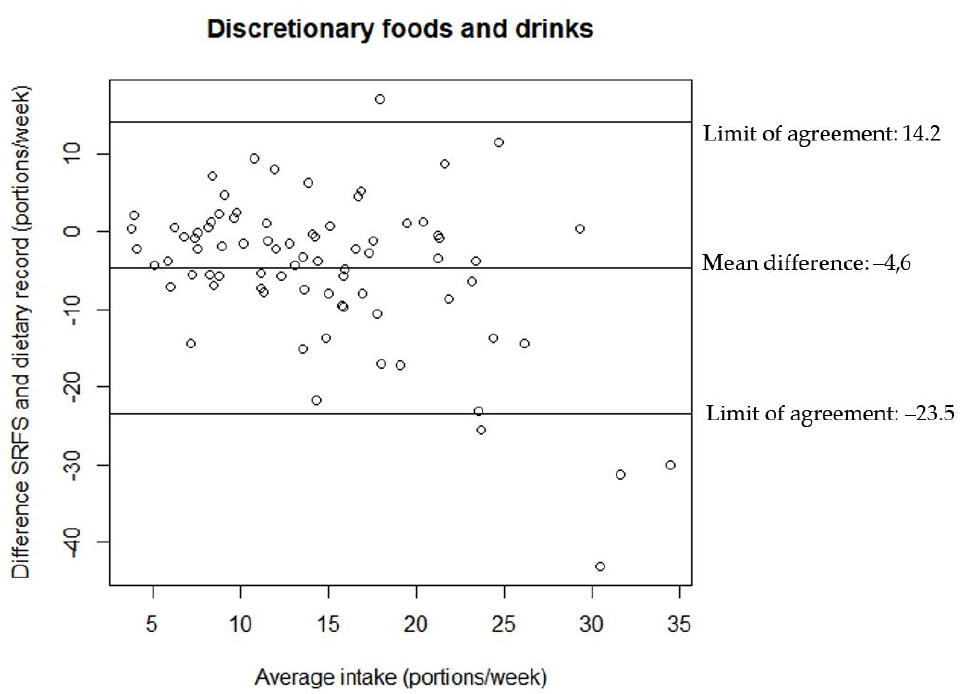
Figure 2. Agreement between the estimated portion intake of discretionary foods and drinks from the SRFS and the 7-day dietary record ( n = 80).